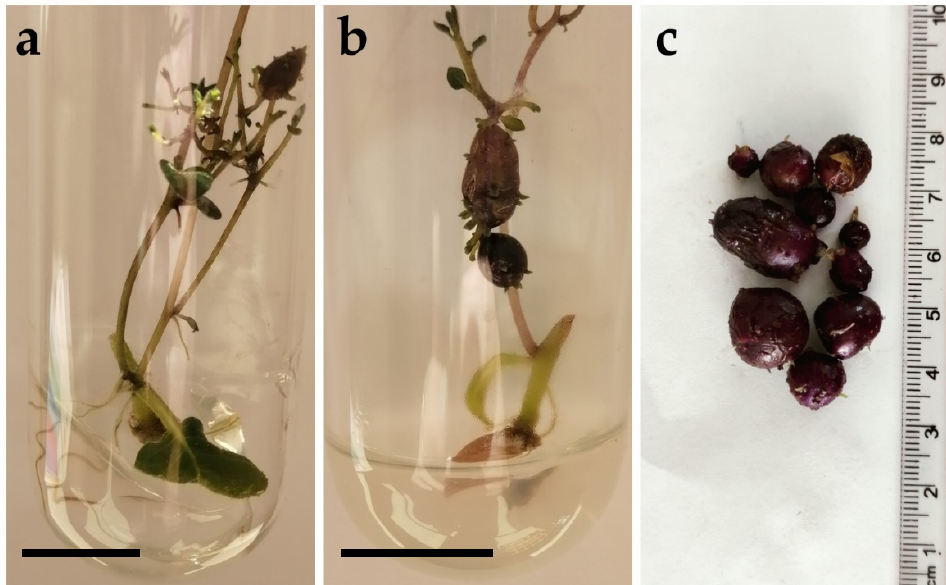
Figure 4. Microtubers obtained from the SB variety on the culture medium MT 2 ; ( a , b ) in vitro microtubers of SB variety; ( c ) microtubers from SB variety generated using MT 2 culture medium. Scale bar represents 1 cm.